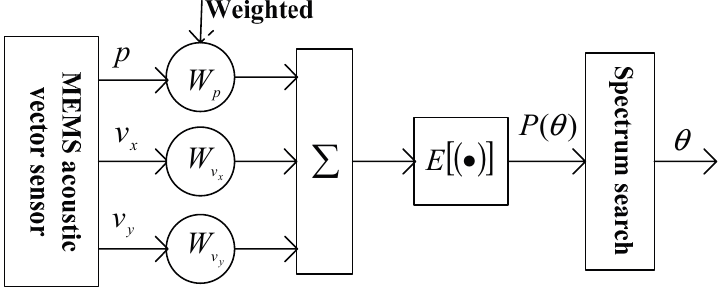
Figure 7. Beam-forming principle block